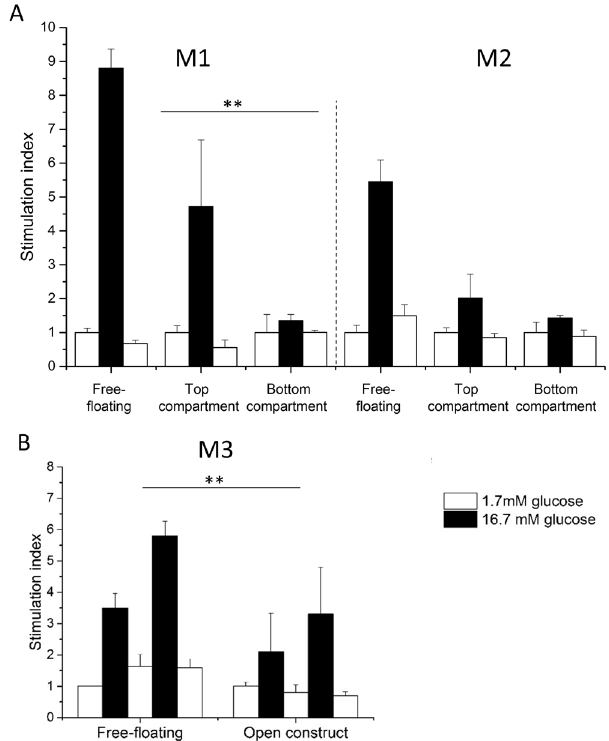
Figure 4. MIN6 aggregates functionality. ( A ) A comparison of MIN6 aggregates insulin secretion detected on the top and bottom compartment separately, in an open transwell system using untreated microwell membranes - M1 and microwell membranes after 2 h treatment with NaClO solution - M2, ( B ) Total insulin secretion of MIN6 aggregates over 5 h using final open construct with microwell membranes after 24 h of treatment with NaClO solution - M3; Insulin secretion is normalized to the first low glucose stimulation and presented as a stimulation index. Error bars indicate standard deviation (n = 3), ** p <